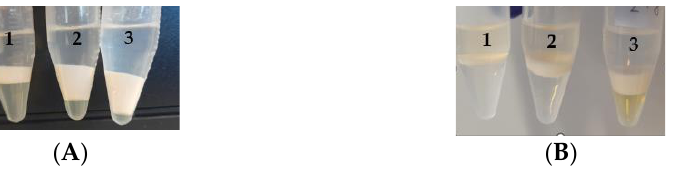
Figure 1. ( A ) Plasma samples after extraction via UV-DLLME with Chl:MeOH at ratios of (1) 4:6 ( v / v ), (2) 3:7 ( v / v ), and (3) 2:8 ( v / v ). ( B ) Plasma samples after extraction via DLLME with Chl:EtOH at ratios of (1) 4:6 ( v / v ), (2) 3:7 ( v / v ), and (3) 2:8 ( v / v ).